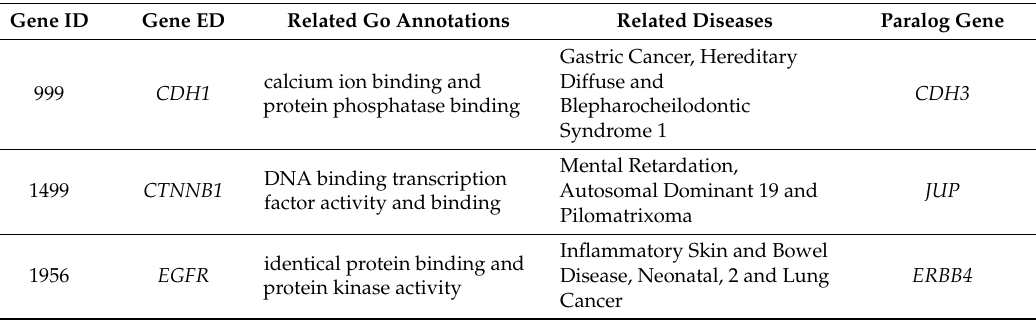
Table 6. Summary of the co-differential genes selected on PAAD, ESCA and